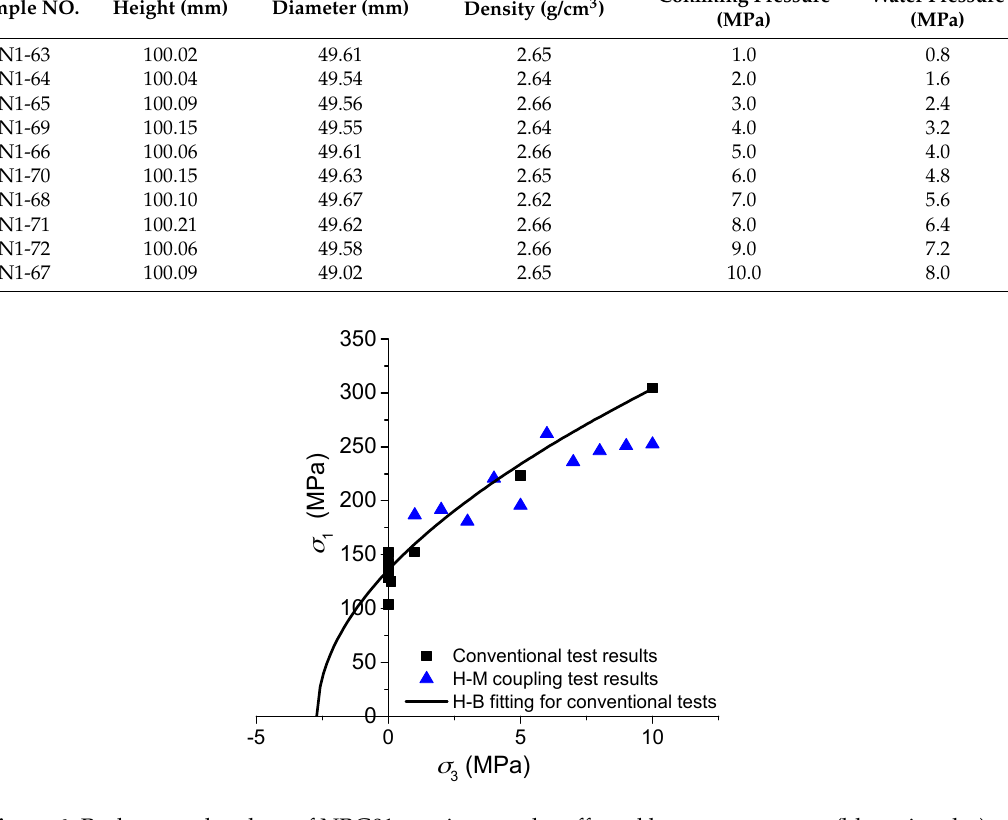
Figure 6. Peak strength values of NRG01 granite samples affected by water pressure (blue triangles) compared with conventional test results under different confinements without any water pressure (black squares).